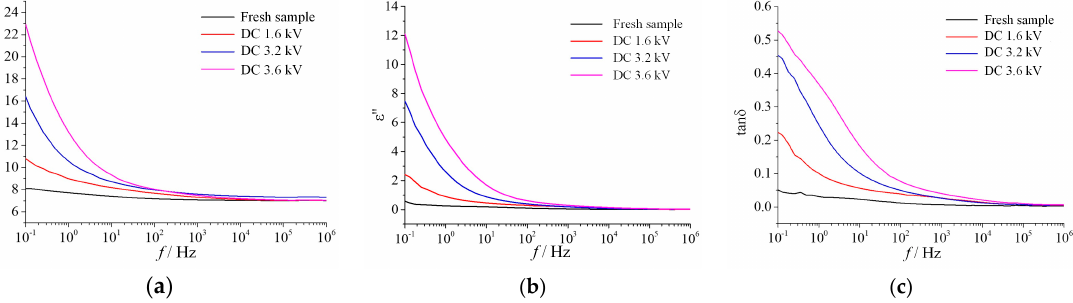
Table 9. Variation of dielectric parameters at different applied voltage ( γ 20 = 1000 μ S/cm, t = 8 h).